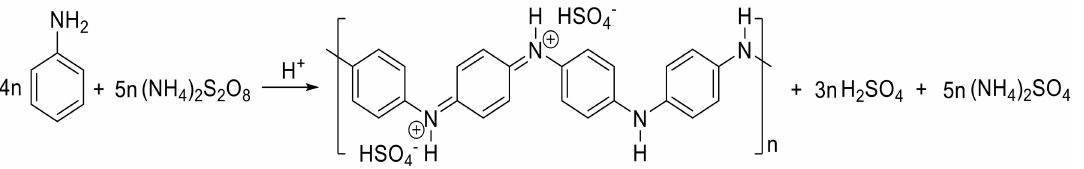
Figure 1. Reaction for the synthesis of